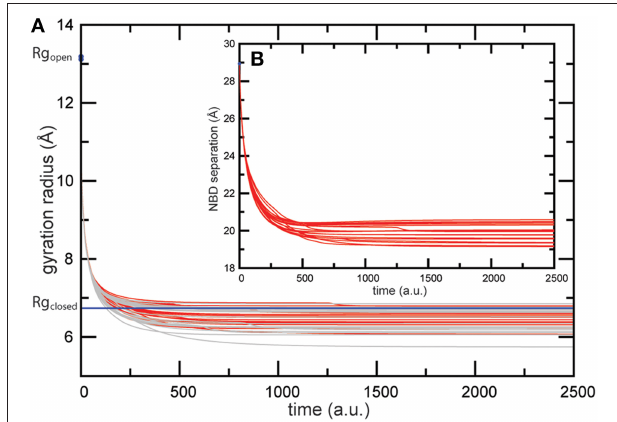
FIGURE 3 | Trajectories of conformational changes in the MalK dimer. Trajectories characterizing conformational motions along the formation of the ligand-bound MalK structures are shown for 20 different ligand-binding realizations. The main panel (A) displays changes in the gyration radius of both pockets (red and gray curves). Corresponding values computed for the ATP-bound crystal structure are shown as blue lines. The inlet (B) displays changes in the separation of the two